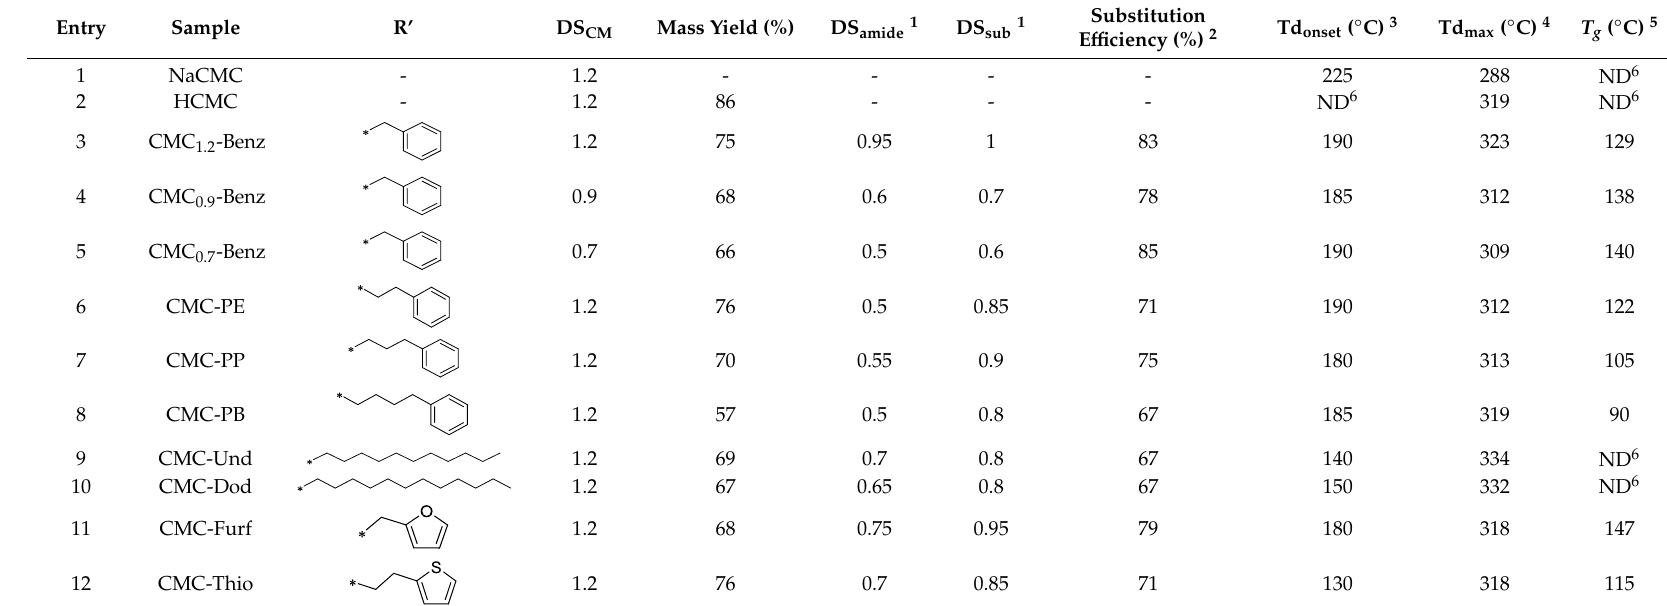
Table 1. Features of the amidated CMC derivatives.